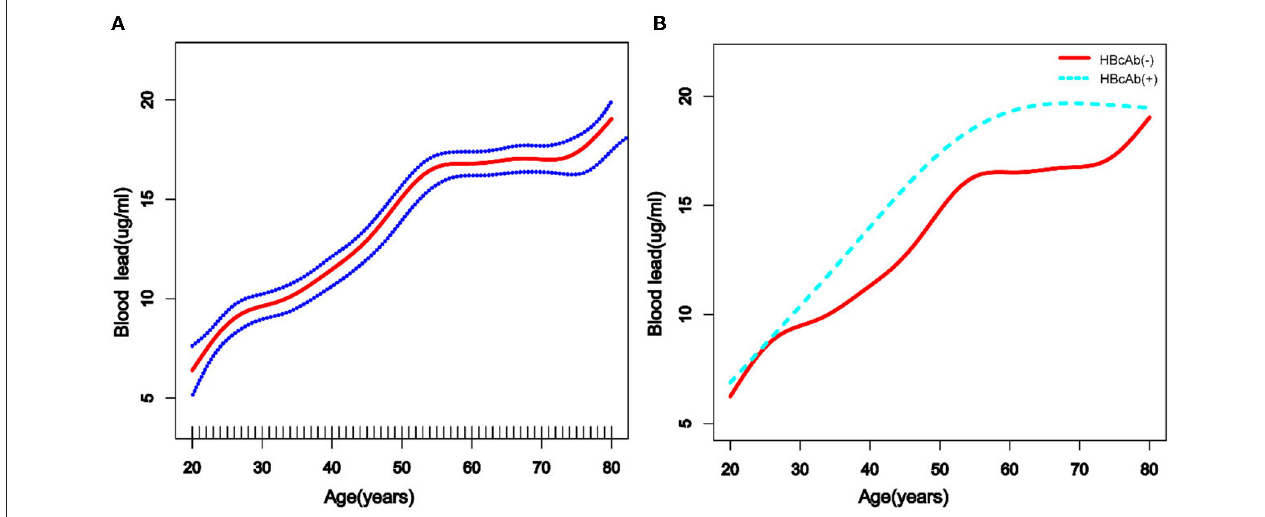
FIGURE 1 | The association between age and blood lead levels. (A) The solid rad line represents the smooth curve fit between variables and a dotted line represents the 95% confidence interval ( CI ) from the fit. All the covariates in the study and Hepatitis B core antibody (HBcAb) were adjusted except age. (B) The solid rad line represents HBcAb (–) and the dotted line represents HBcAb ( + ). All the covariates in the study are adjusted.